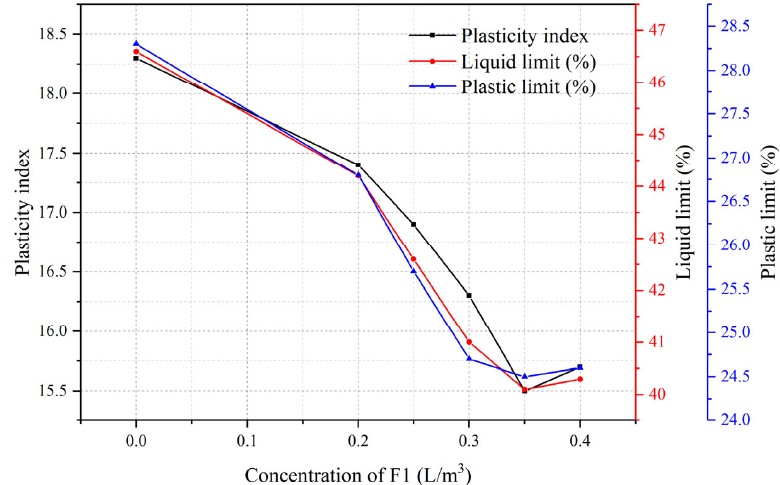
Figure 3. The relationship between concentration of F1 and Atterberg limits.